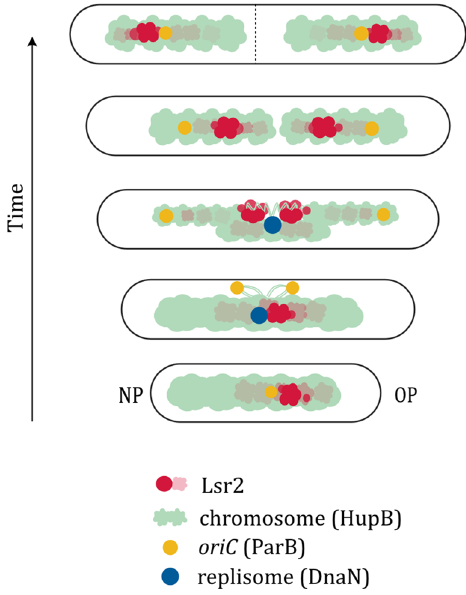
Figure 6. Cartoon illustrating the subcellular localization of Lsr2 during the mycobacterial cell cycle. Lsr2 forms one or two major nucleoprotein complexes. At the beginning of the cell cycle, the single Lsr2 complex is localized slightly asymmetric in relation to the midcell near the oriC region. Soon after the initiation of DNA replication, the newly replicated oriC regions are rapidly segregated towards the opposite cell poles, while Lsr2 remains localized in the vicinity of replisomes. Next, major Lsr2 complex splits into complexes, which move towards the opposite cell poles where the segrosomes are already located. The cartoon is based on the results obtained from our TLFM (Fig. 4) and PALM (Fig. 5)